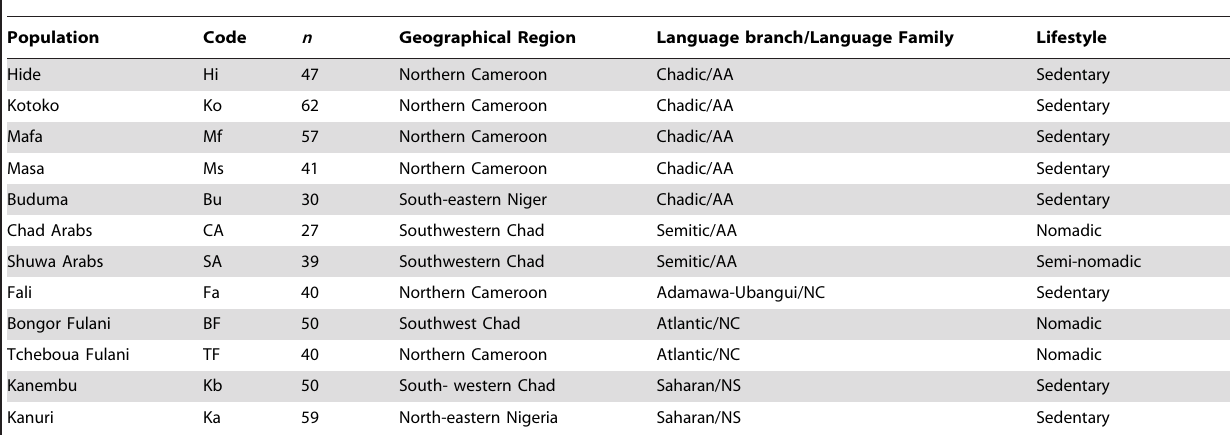
Table 1. Populations analyzed in the present